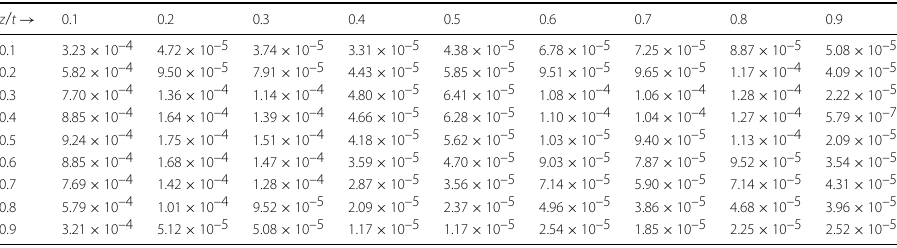
Table 2 Absolute errors for Example 1 by IRKM [31] at t = 1 when α = 0.7, N = 100, and (cid:3) t = 0.001